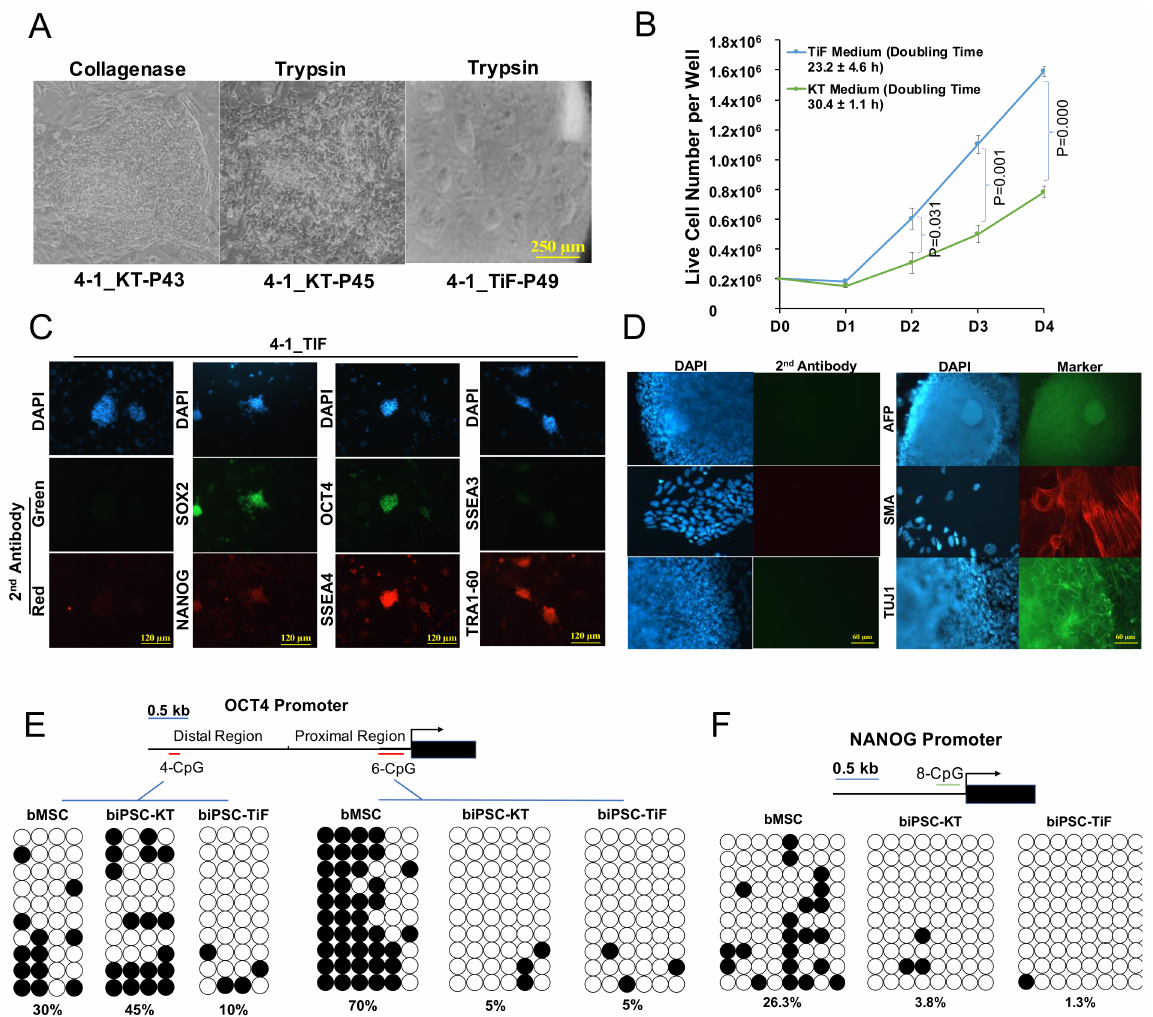
Figure 3. Characterization of naïve-like bovine iPSCs. ( A ): Flat, monolayered primed-like 4-1 biPSC colonies cultured in KT medium and passaged with collagenase (left), deteriorated colony morphology upon trypsinization (middle), and dome- shaped, naïve-like biPSCs cultured in TiF medium and passaged with trypsin (right), bar = 250 µ m. ( B ): Cell proliferation difference between naïve and primed-like biPSCs. Mean ± sd, n = 3. Student’s t-test was used for data comparison. ( C ): immunostaining of naïve-like 4-1 biPSCs in TiF medium with OCT4, NANOG, SOX2, SSEA3, SSEA4, TRA-1-60 antibodies. Bar = 120 µ m. ( D ): Immunostaining of EBs derived from naïve-like biPSCs for three-germ layer markers (AFP for endoderm, SMA for mesoderm, and TUJ1 for ectoderm) after passaging of the EBs, bar = 120 µ m. ( E ): Bisulfite sequencing results of bovine OCT4 distal enhancer (Left Panel) and proximal promoter (Right Panel) genomic regions. Open and closed circles represent unmethylated and methylated CpGs, respectively. The percentage of methylated CpG is shown at the bottom of each sample. ( F ): Bisulfite sequencing results of bovine NANOG promoter genomic region. Open and closed circles represent unmethylated and methylated CpGs, respectively. The percentage of methylated CpG is shown at the bottom of each